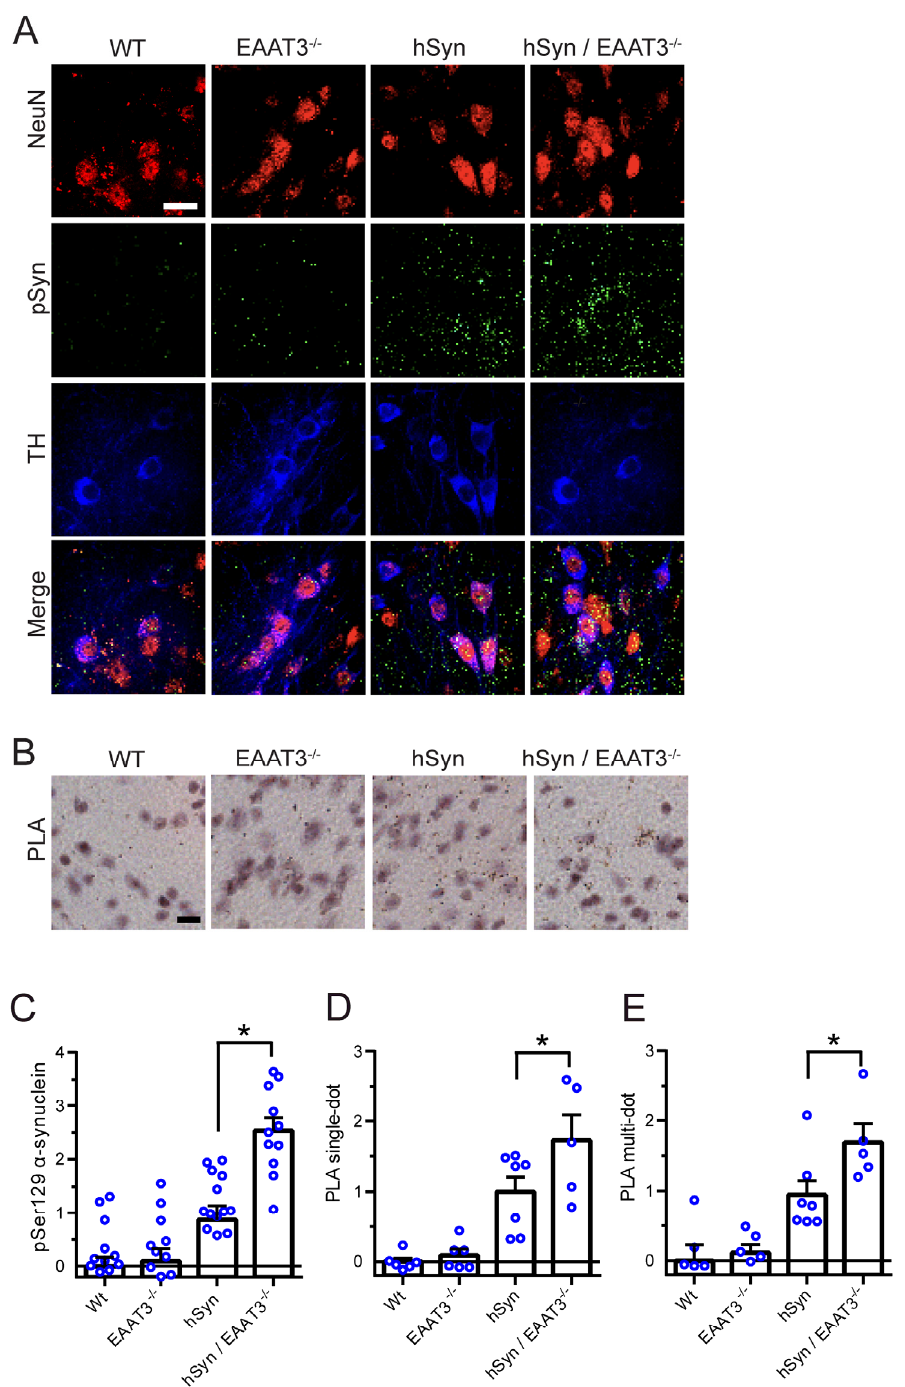
Figure 4. Increased α -synuclein aggregation in substantia nigra neurons of hSyn/EAAT3 − / − mice. ( A ) Immunostaining for phosphoserine-129 α -synuclein (pSyn; green) in dopaminergic neurons, with neuronal nuclei identified by NeuN (red) and dopaminergic neurons identified by tyrosine hydroxylase (TH; blue). ( B ) α -synuclein aggregates are identified by proximity ligation assay (PLA). Scale bars = 20 µ m. ( C ) Quantification of pSyn immunostaining; * p < 0.05, n = 8–11. ( D ) Quantification of single-puncta PLA signals; * p < 0.05, n = 5–7. ( E ) Quantification of multi-puncta PLA signals. For all quantifications, data from each mouse isare expressed relative to signal measured in hSyn mice sections prepared and analyzed in